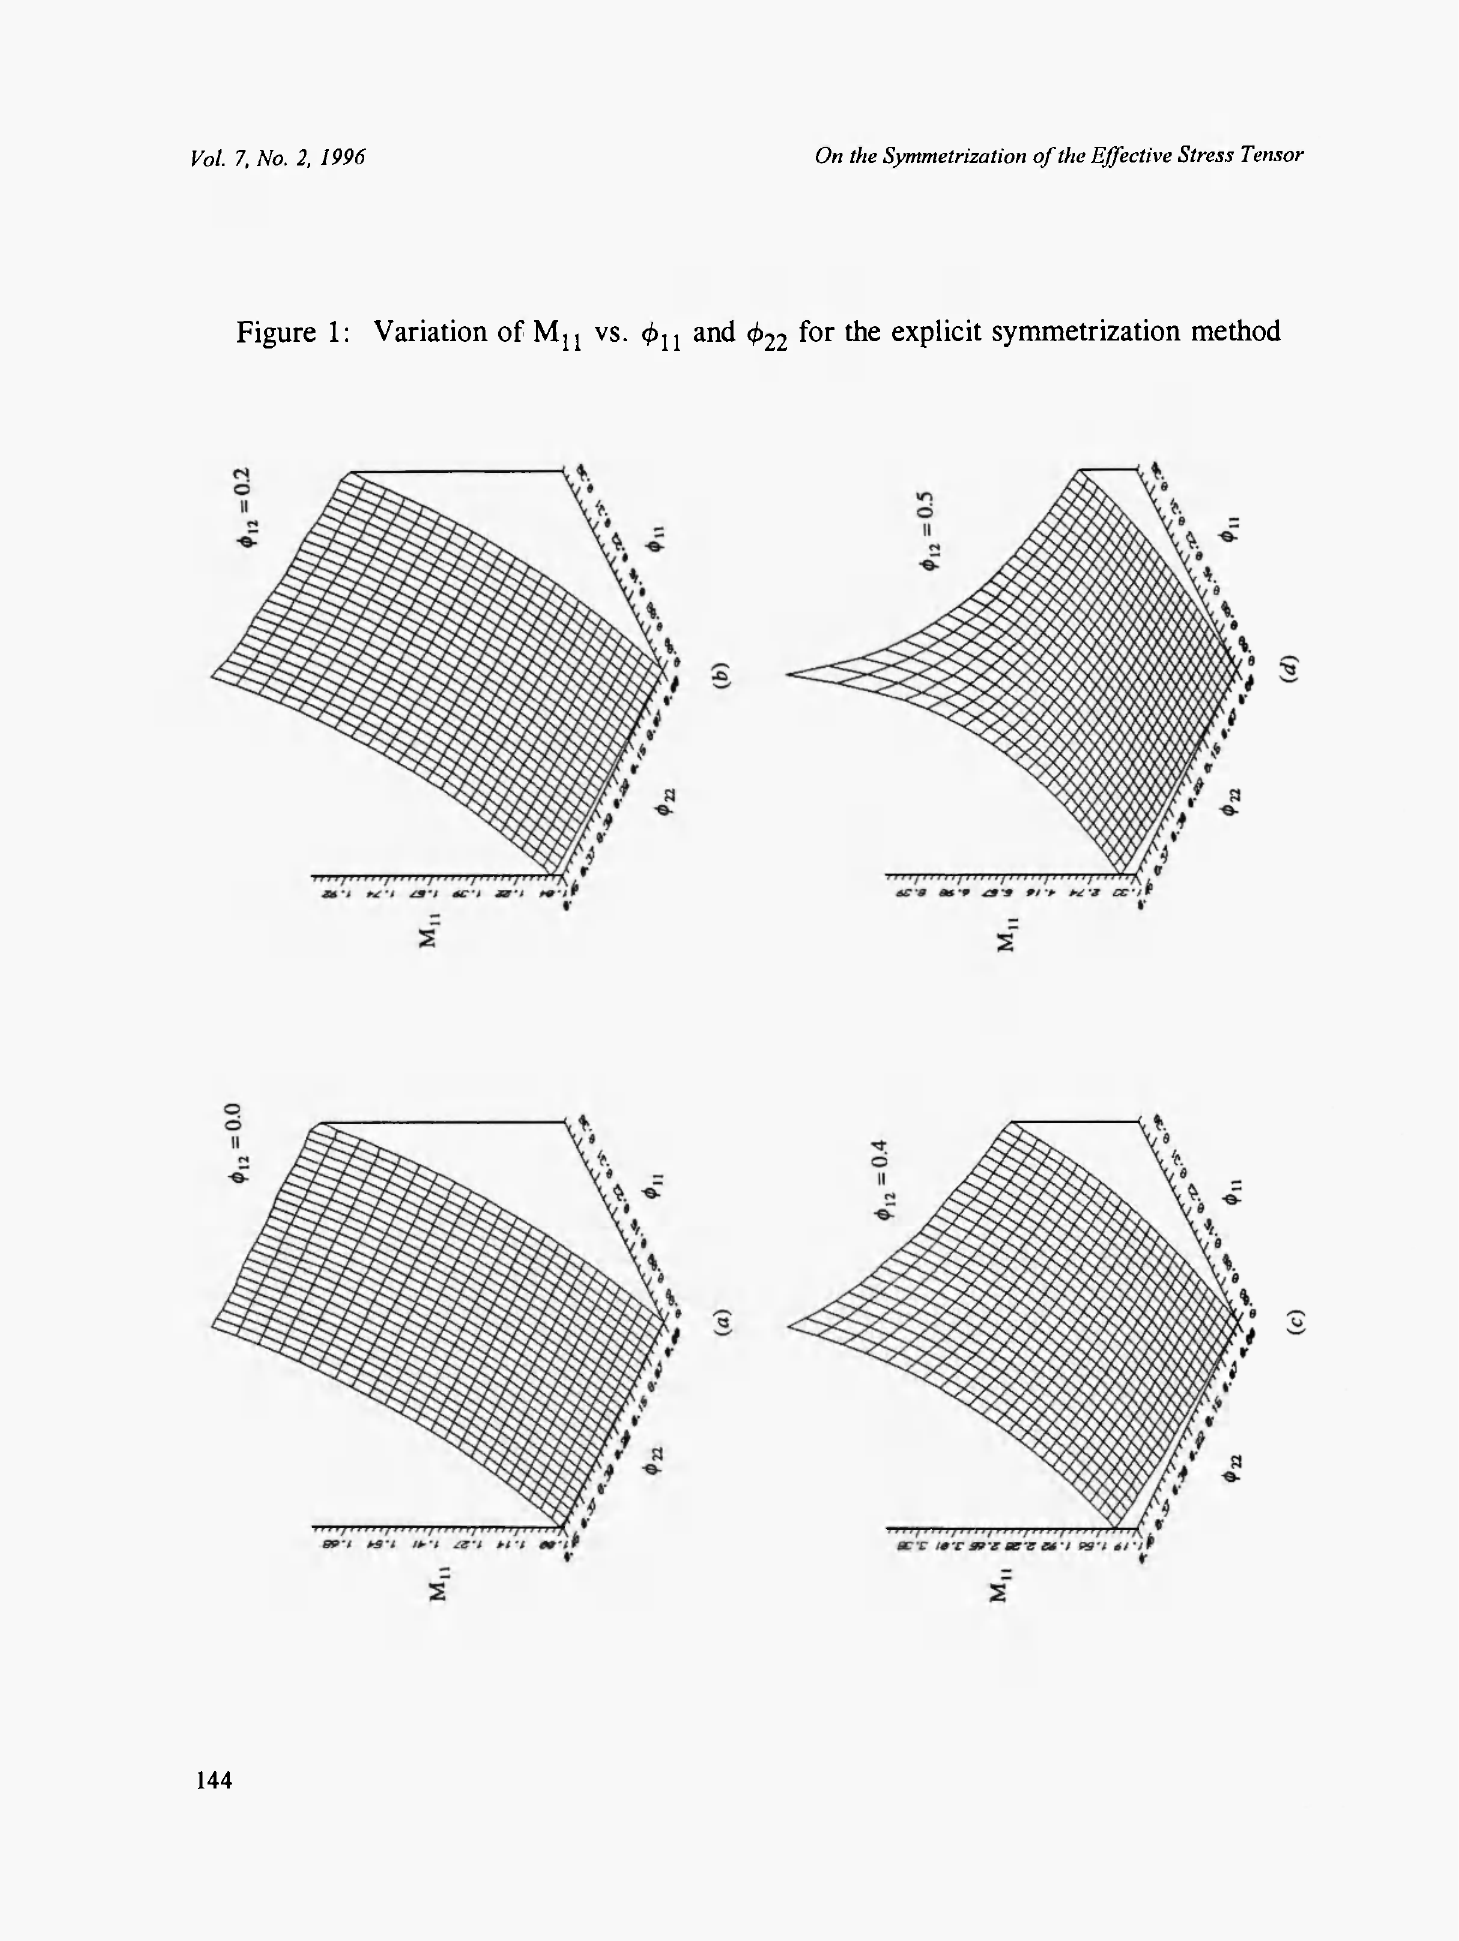
Figure 1: Variation of M